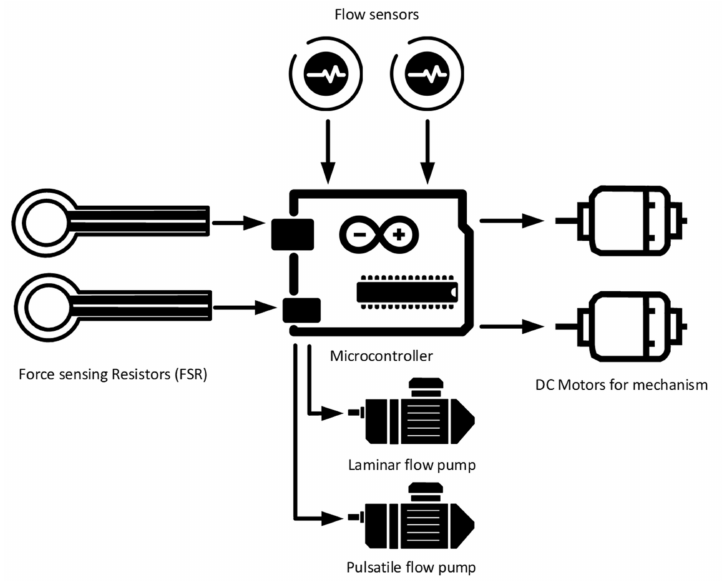
Figure 23. Overall circuit diagram of the